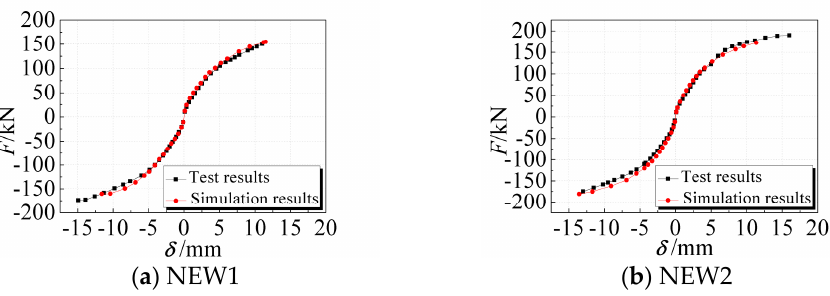
Figure 15. Comparison of test and calculated skeleton curves.